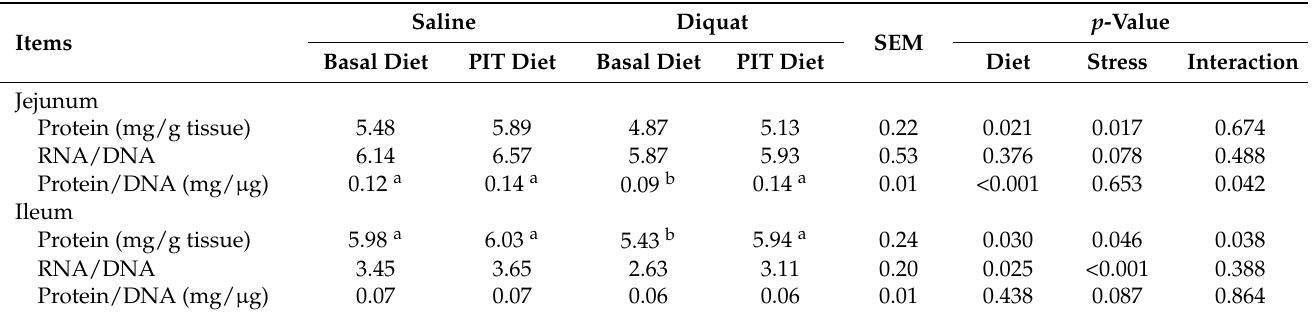
Table 5. The contents of intestinal mucosal protein, DNA and RNA of the piglets fed polyphenols sourced from Ilex latifolia Thunb. (PIT) diets under oxidative